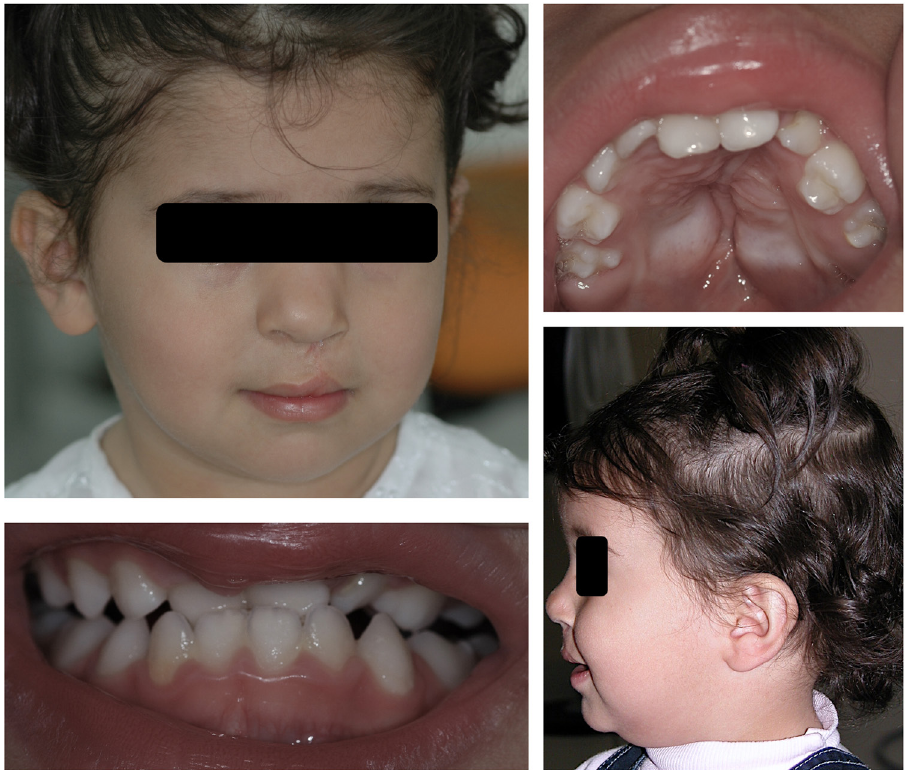
Figure 2. Follow-up records at age